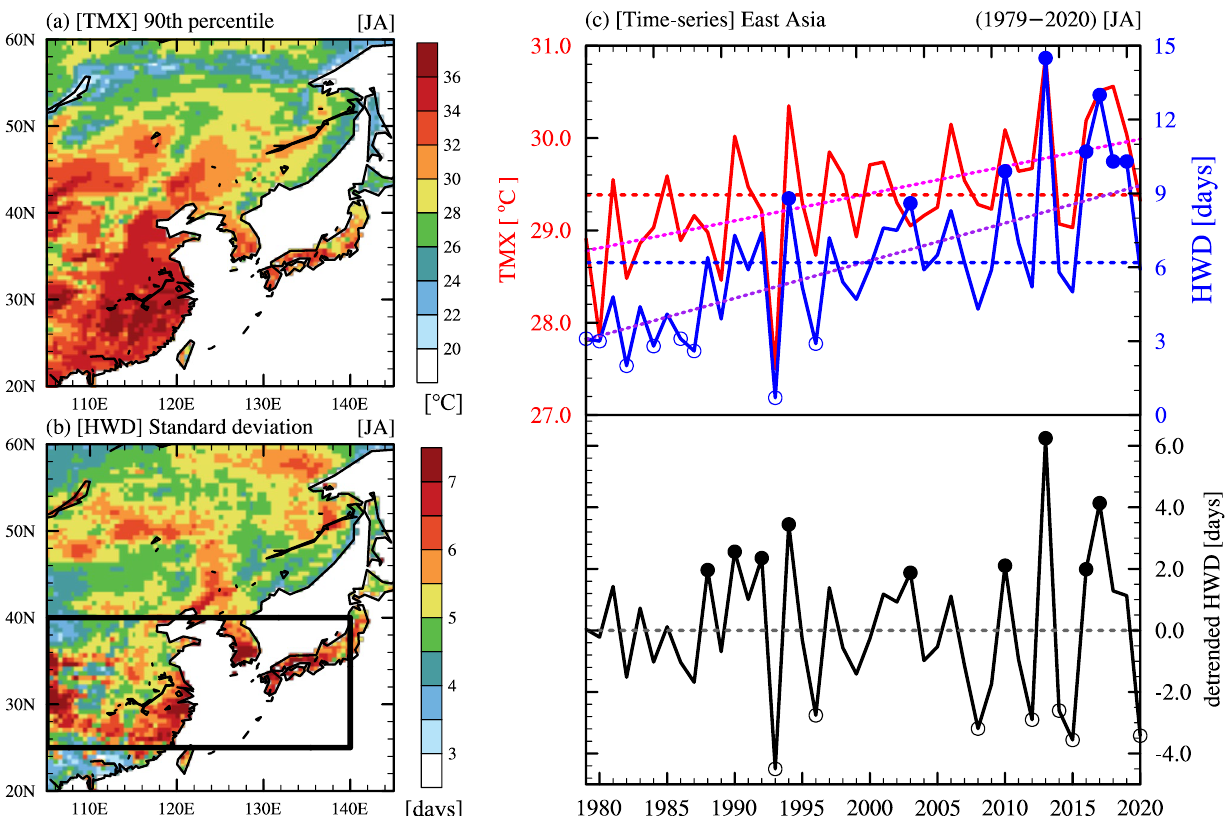
Figure 1. Climatological features of maximum temperature (TMX) and heatwave days (HWD) in East Asia. ( a ) 90th percentile of daily TMX (unit: °C) (1979–2020) in peak summer (July–August), and ( b ) standard deviation of HWD (unit: days). The black rectangle indicates the area of interest in East Asia where the standard deviations of HWD are high. ( c ) Time series of TMX (red solid line), HWD (blue solid line), and detrended HWD (black solid line) in the black rectangle area in ( b ). The open and closed circles indicate heatwave years in East Asia (HWY-EA) and non-heatwave years in East Asia (NHWY-EA), identified from the HWD with the trend (blue) and detrended HWD (black), respectively. The horizontal dashed lines indicate the climatological mean and the pink and purple dotted lines indicate the